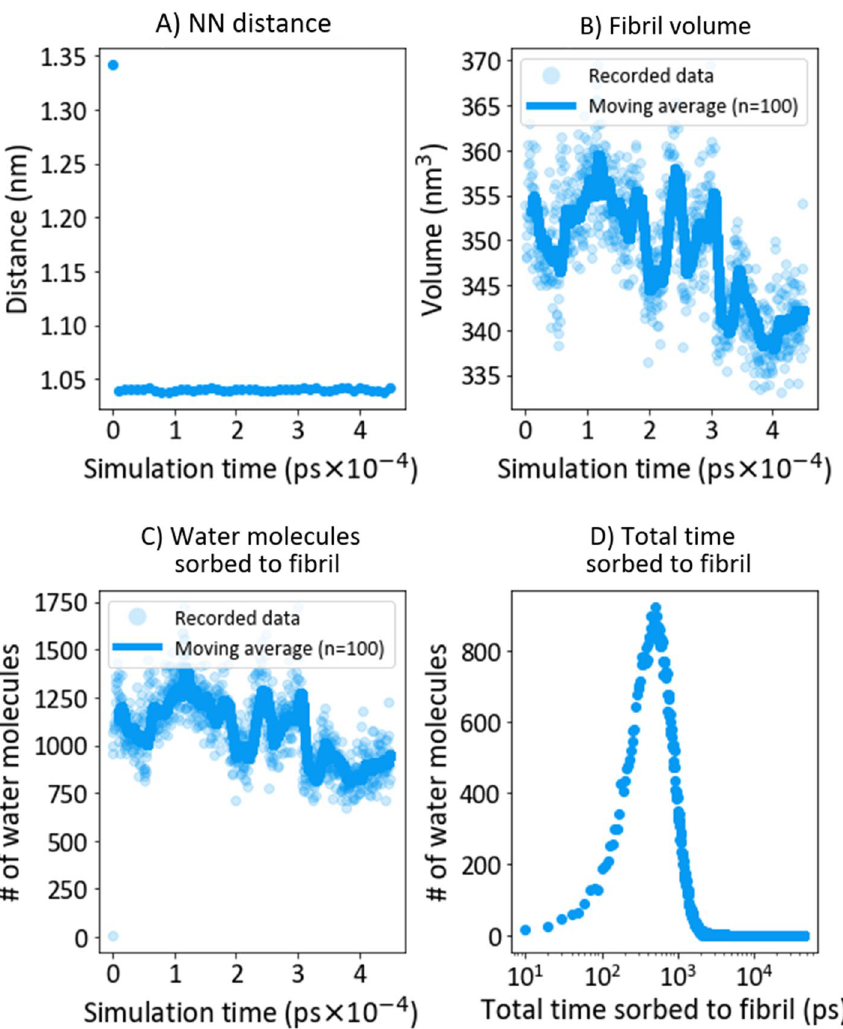
Figure 4. Swelling at 25 °C. ( A ) Nearest neighbour (NN) distance, ( B ) the bundle volume, ( C ) the number of sorbed water molecules, and ( D ) the total time water was sorbed to a